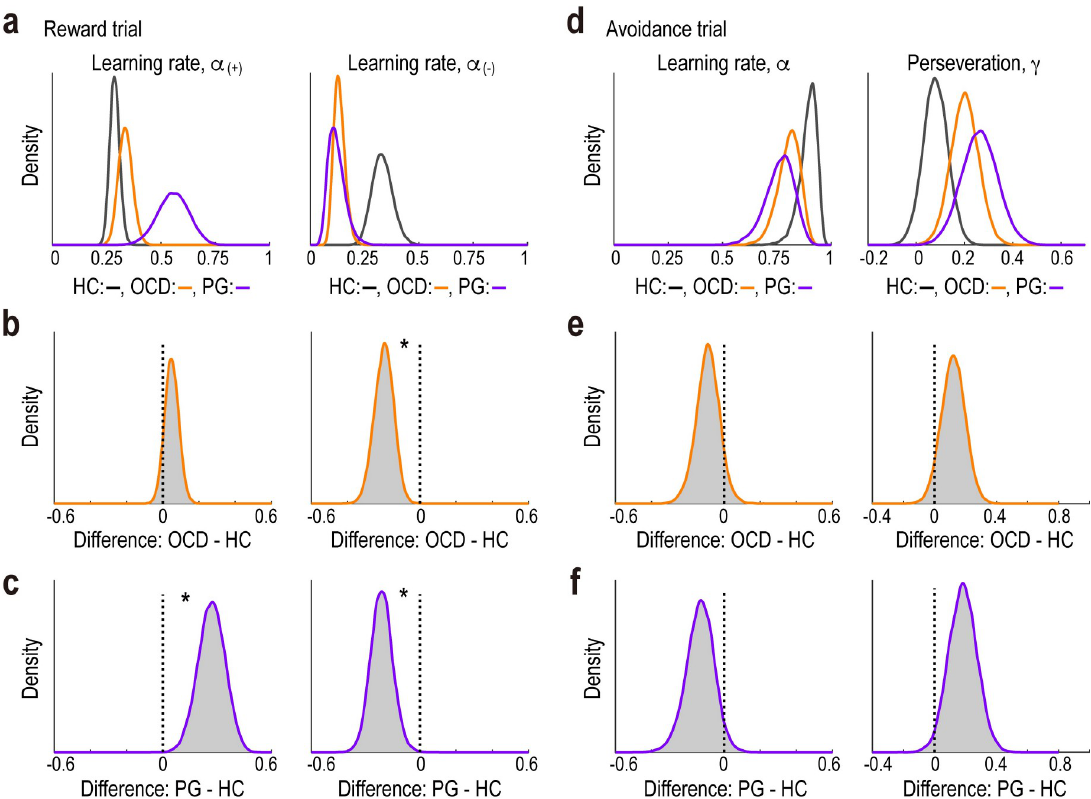
Fig 4. Parameter estimates in the best-fitted models. (a) Posterior distributions of group-level mean parameters of RL2 in reward trials for each group. Left , learning rate from the positive reward prediction error, α (+) . Right , learning rate from the negative reward prediction error, α (-) . Grey , healthy control (HC); orange , obsessive-compulsive disorder (OCD); purple , pathological gambling (PG). (b) Posterior distributions of the difference between the OCD and HC groups in reward trials. Left , α (+) ; and right , α (-) . � BF > 20 denotes “very strong” or “strong” evidence [100] for the difference. BF, Bayes factor. (c) Posterior distributions of the difference between the PG and HC groups in reward trials. The format is the same as in (b). (d) Posterior distributions of group-level mean parameters of RL3 in avoidance trials for each group. Left : learning rate, α ; right : perseveration, γ . The format is the same as in (a). (e) Posterior distributions of the difference between the OCD and HC groups in avoidance trials. Left , α ; right , γ . The format is the same as in (b). (f) Posterior distributions of the difference between the PG and HC groups in avoidance trials. The format is the same as in (b). Summary data to reproduce the figure are available at